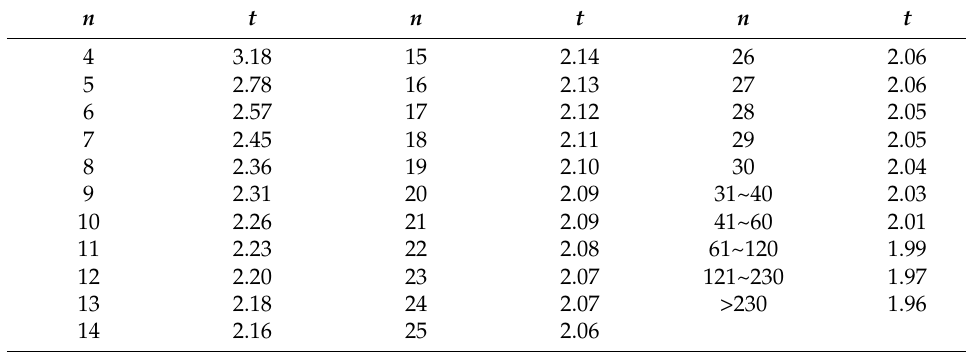
Table A1. The complete data of functional relationship between n and t